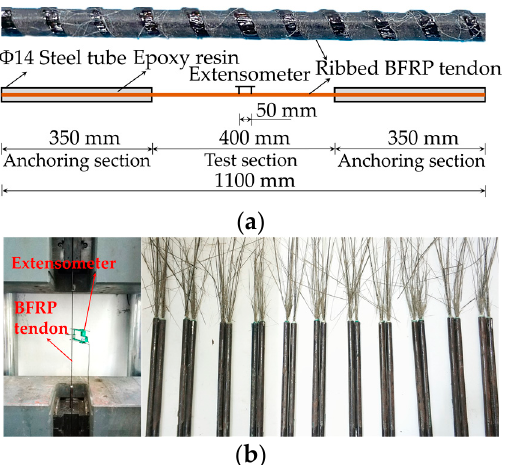
Figure 3. Tensile test of BFRP tendons: ( a ) anchoring scheme and ( b ) loading and failure.